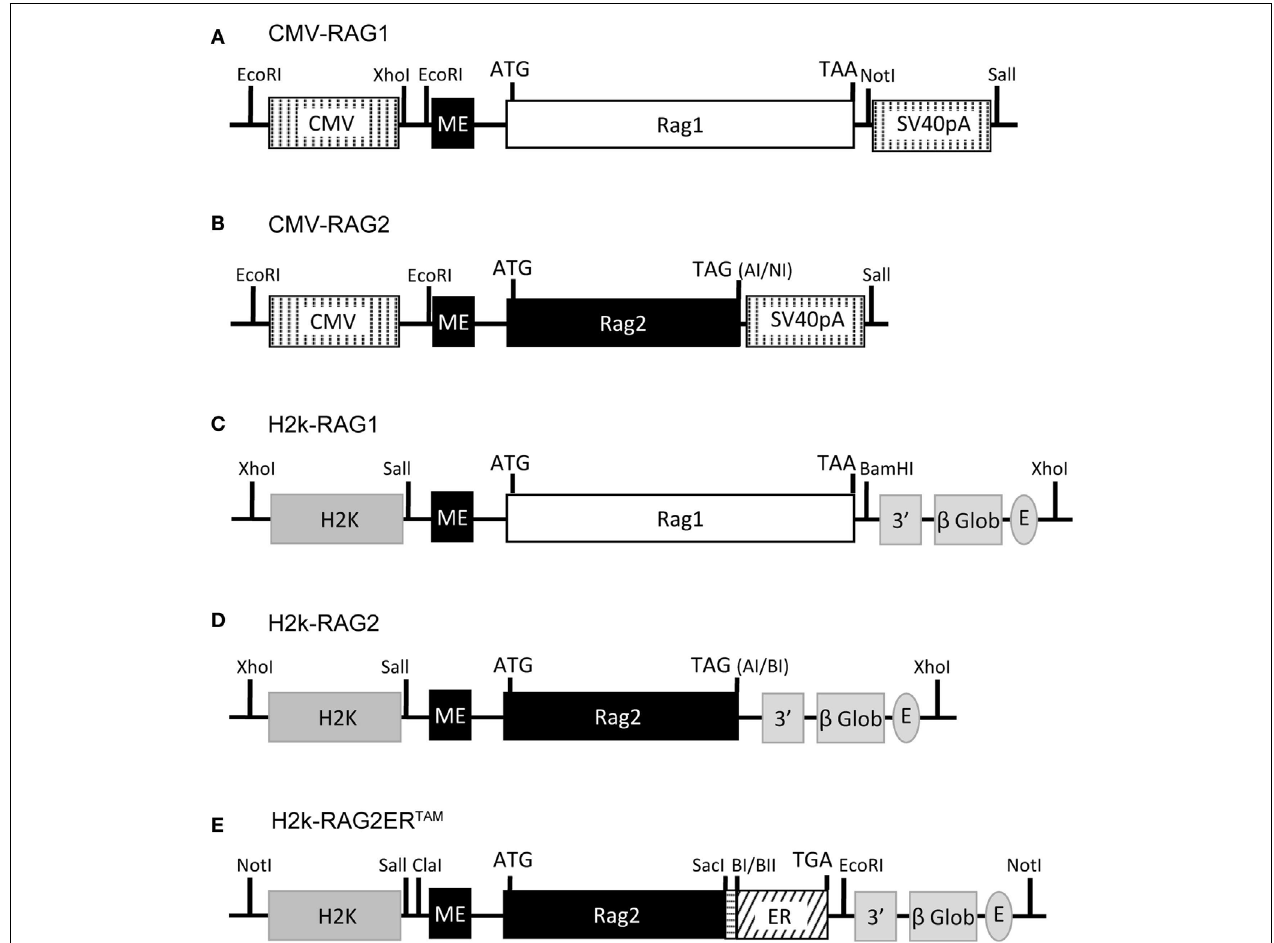
receptor (ER, slant dashed box) that ends in the stop codon (TGA).The CMV expression cassette (A,B) contains the CMV viral promoter (5 (cid:48) vertical dashed box), an engineered first exon of the RAG2 gene ( RAG2 miniexon; ME, small black box) and the SV40-polyA (3 (cid:48) vertical dashed box).The H2k expression cassette (C,D) contains the H2k mouse MHC class I promoter (5 (cid:48) gray box), the RAG2 miniexon (ME, small black box), the 3 (cid:48) untranslated region of the human β -globin gene, including a splice site and the polyA (3 (cid:48) gray boxes), and the E µ enhancer (gray oval). Restriction sites are identified and depicted as vertical lines (except for: AI, Ase I; NI, Not I; BI, Bam HI; and BII, Bgl